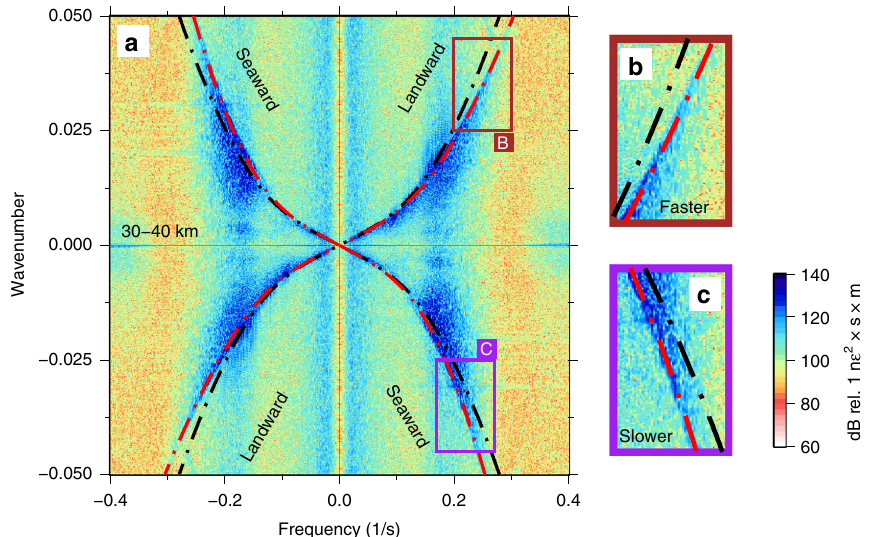
Fig. 8 Ocean currents. a Raw distributed acoustic sensing frequency – wavenumber spectrum calculated over 10 min between 30 and 40 km, showing asymmetrical dispersion due to an ocean current. b , c Insets to a illustrating how landward-propagating ocean waves exhibit faster velocities than seaward- propagating ocean waves. The theoretical dispersion curves for ocean surface gravity waves are plotted with (red) and without (black) the effect of a mean fl ow (Fig. 8a) landward- and seaward-propagating waves are of similar strength (see also Fig. 7a). Because the strength of seaward- propagating waves is greater on the outermost segment of the cable than on the next segment closer to shore, we infer that some the bathymetric ridge at 30 km. Inboard of the 30-km ridge, we energy decreases systematically, which is consistent with the